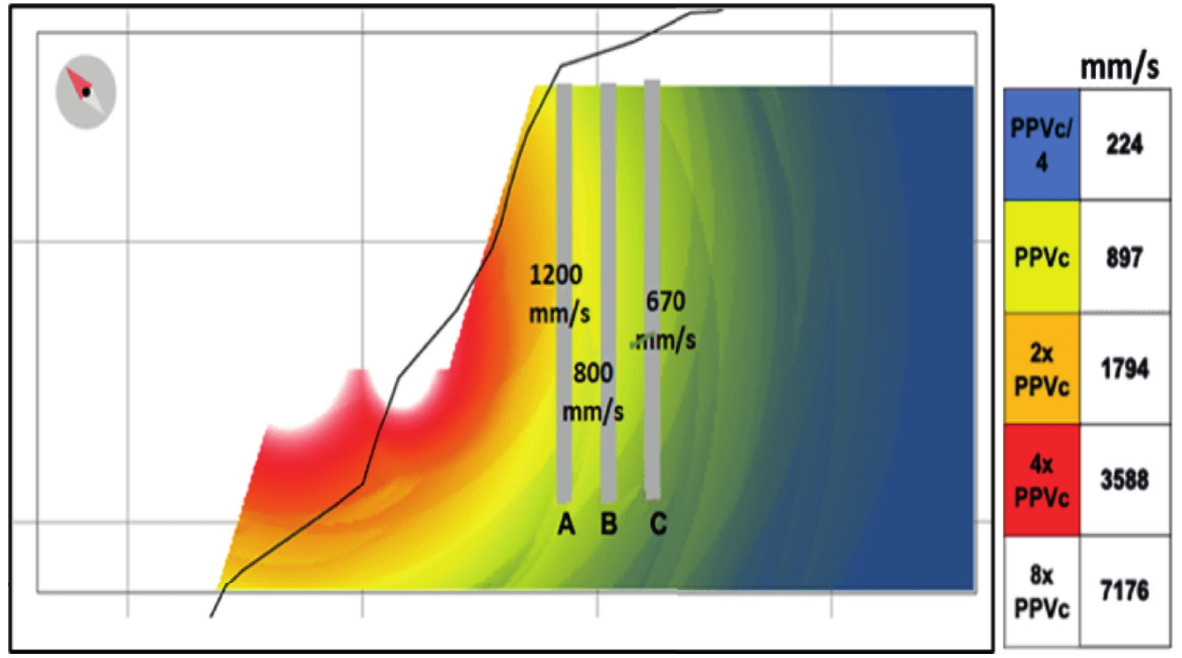
Figure 7. Vibration heat map showing the inspected holes A B C in gray, expected induced damage based on PPVc and the actual slope in black for blast test 1. Fracturing is expected throughout the yellow zone and the distance between the last row of boreholes until its border is around 13 m.